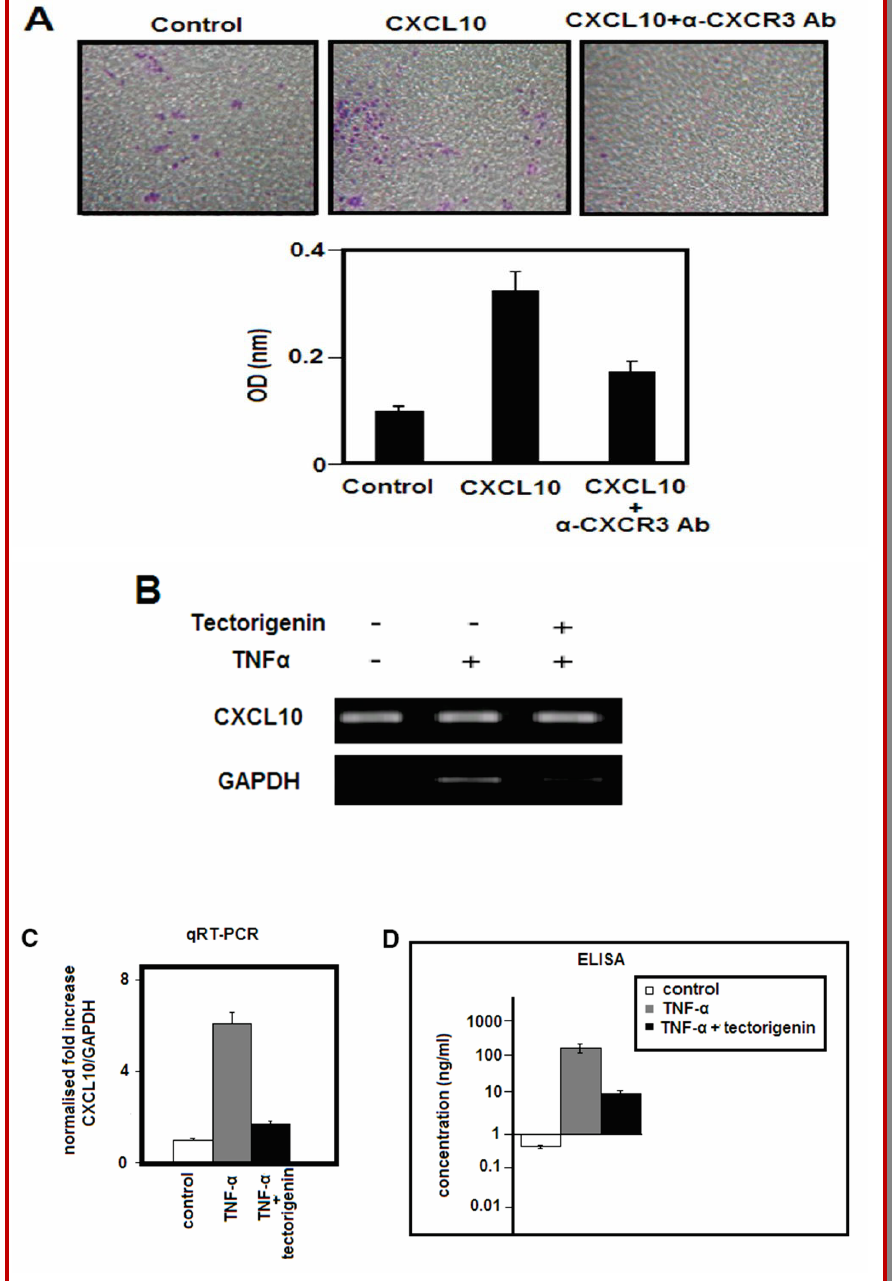
Figure 3: Tectorigenin inhibitory effect on TNF- α induced CXCL10 expression. (A) Caco-2 cells stimulation with control or CXCL10 (20 ng/mL) in the presence or absence of anti-CXCR3 antibody (5 µg/mL). (B) CXCL10 and GAPDH mRNA expression analysis: Caco-2 cells alone or treated with TNF- α (10 ng/mL) in the absence or presence of tectorigenin (20 µM) for 12 hours. (C) mRNA quantification using RT-PCR samples prepared in (A). (D) ELISA test: Caco-2 cells alone or treated with TNF- α (10 ng/mL) in the absence or presence of tectorigenin (20 µM) for 12 hours. All the data shown indicated the mean ± SD for one experiment performed in clonogenic survival activity within one week, respec- tively (Figure 2B and 2C). That is, tectorigenin exposure arrested the invasion effect of Caco-2 cancer cells upon TNF- α inducement.